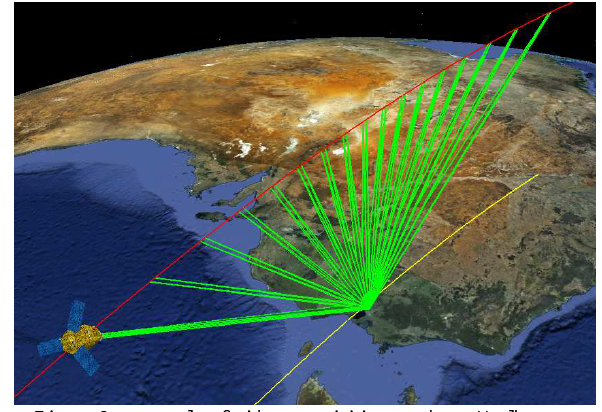
Figure 2 : example of video acquisition mode on